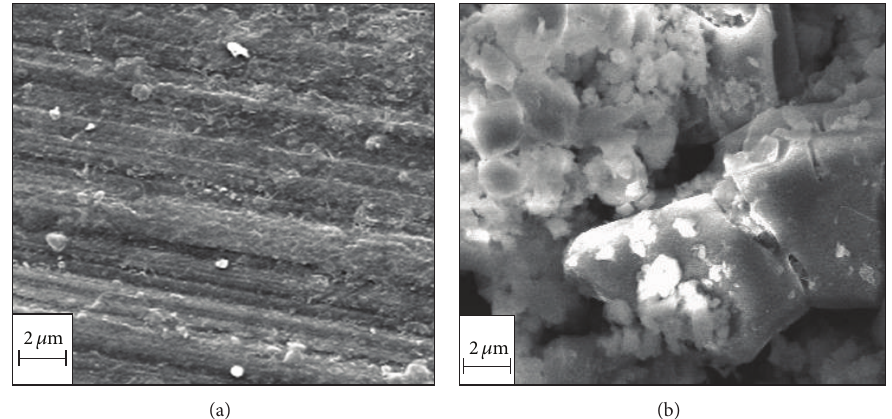
Figure 5: SEM micrograph of fused metal surface oxide morphology, (a) before and (b) after being subjected to oxidation test for 40 hours at 600 ∘ C.